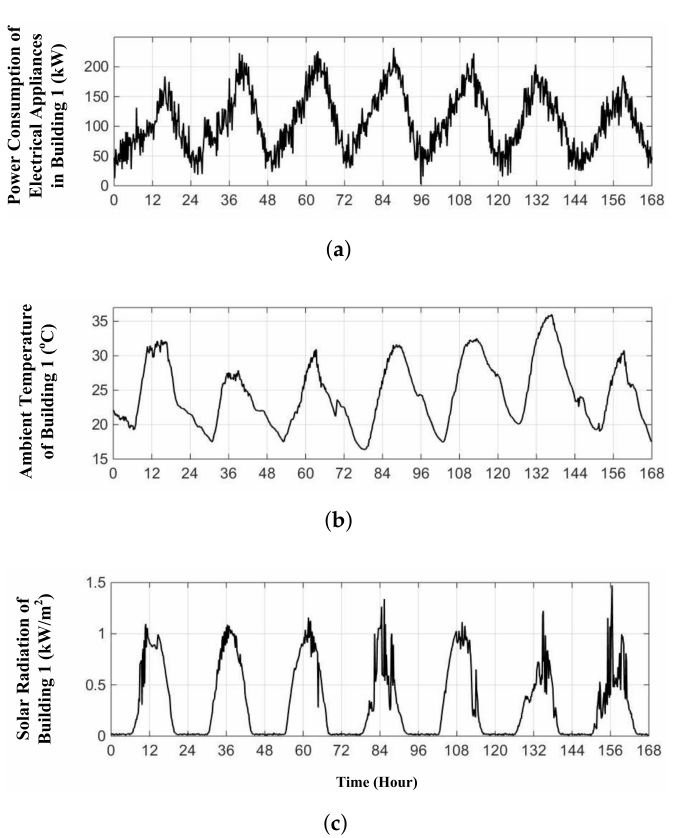
Figure 4. Representative profiles of: ( a ) power consumption of electrical appliances (excluding building air-conditioning systems (BACS)) in building 7 (kW); ( b ) ambient temperature of building 7 ( ◦ C); ( c ) solar radiation of buiding 1 (kW/m 2